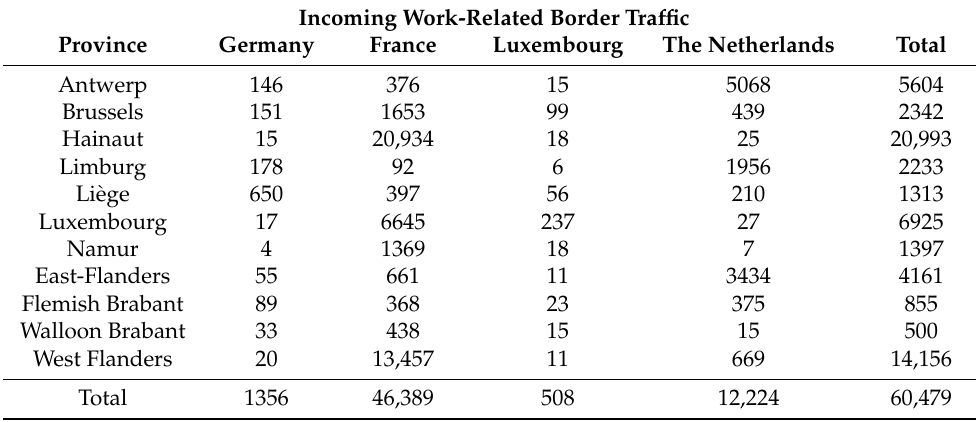
Table 2. Number of people living in a neighboring country but working in